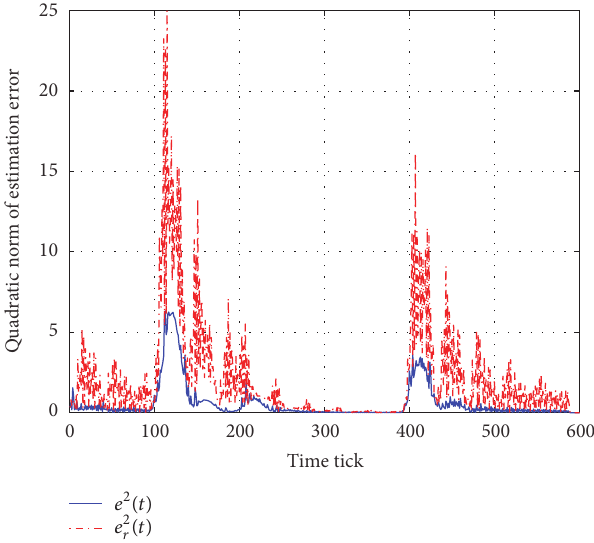
Figure 7: Quadratic norm of estimation errors for RTZ policy.